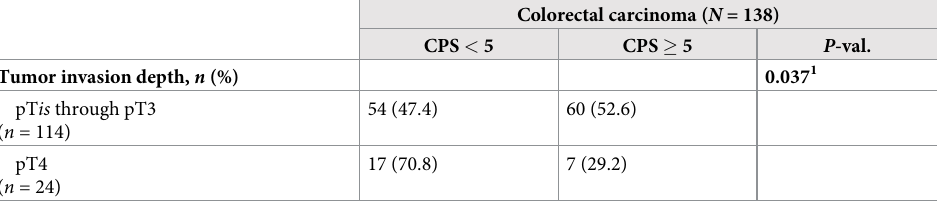
Table 3. PD-L1 CPS according to tumor invasion depth of CRC.